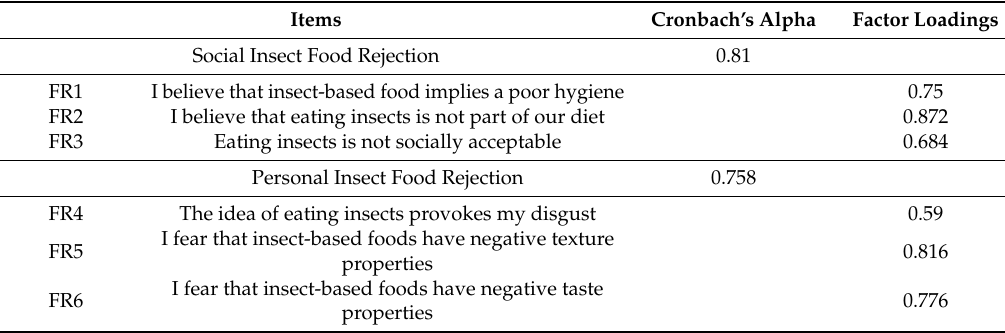
Table 4. Confirmatory factor analysis of the insect food rejection (FR)